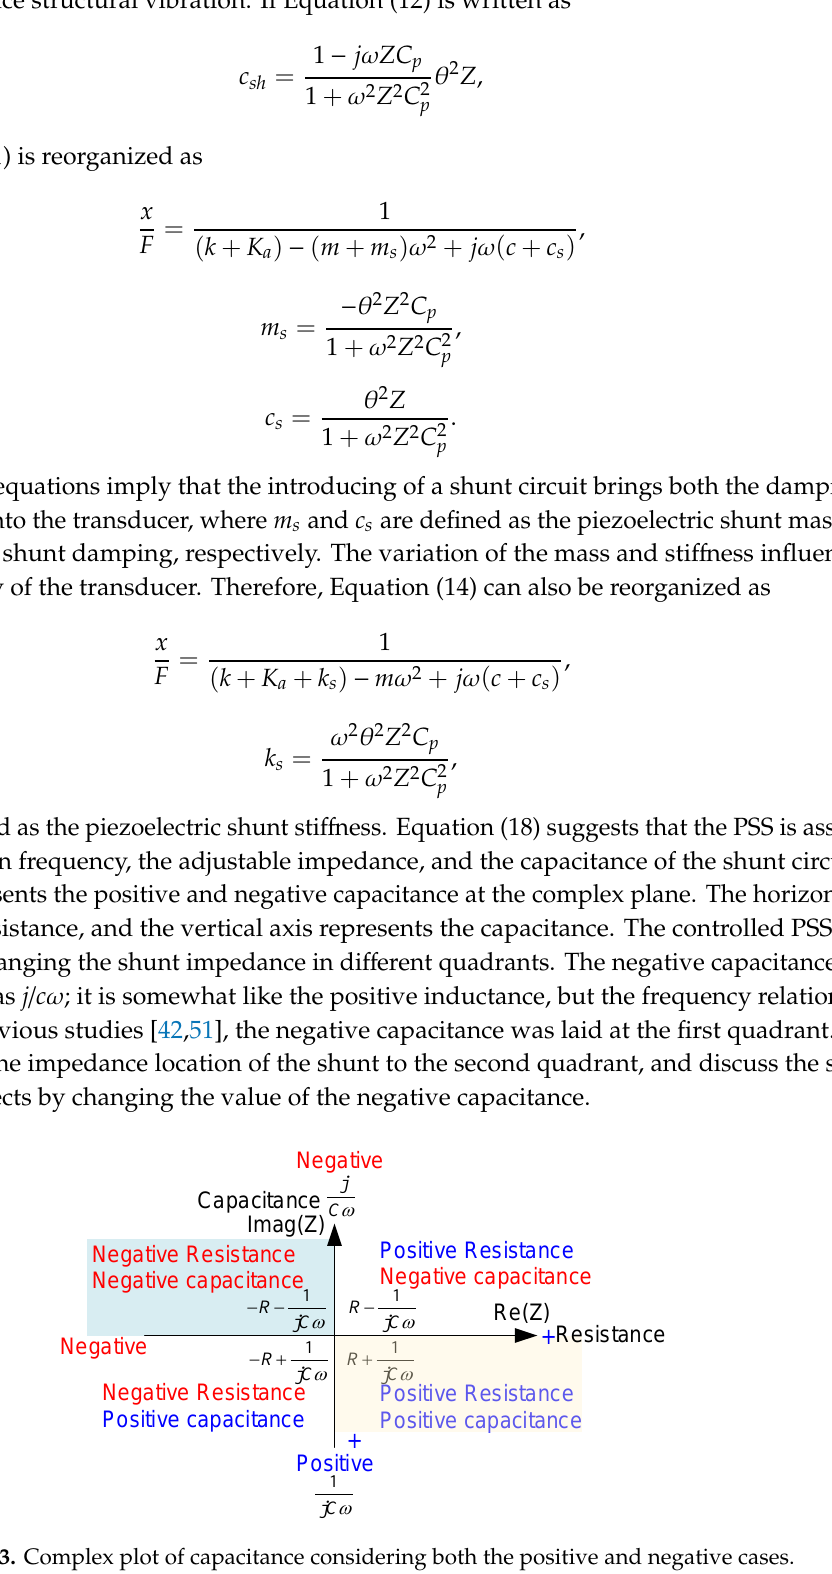
Figure 3. Complex plot of capacitance considering both the positive and negative